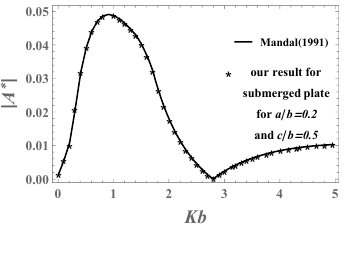
Figure 2. | A ∗ | vs Kb for partially immersed plate for c/b = 0 . 4 .